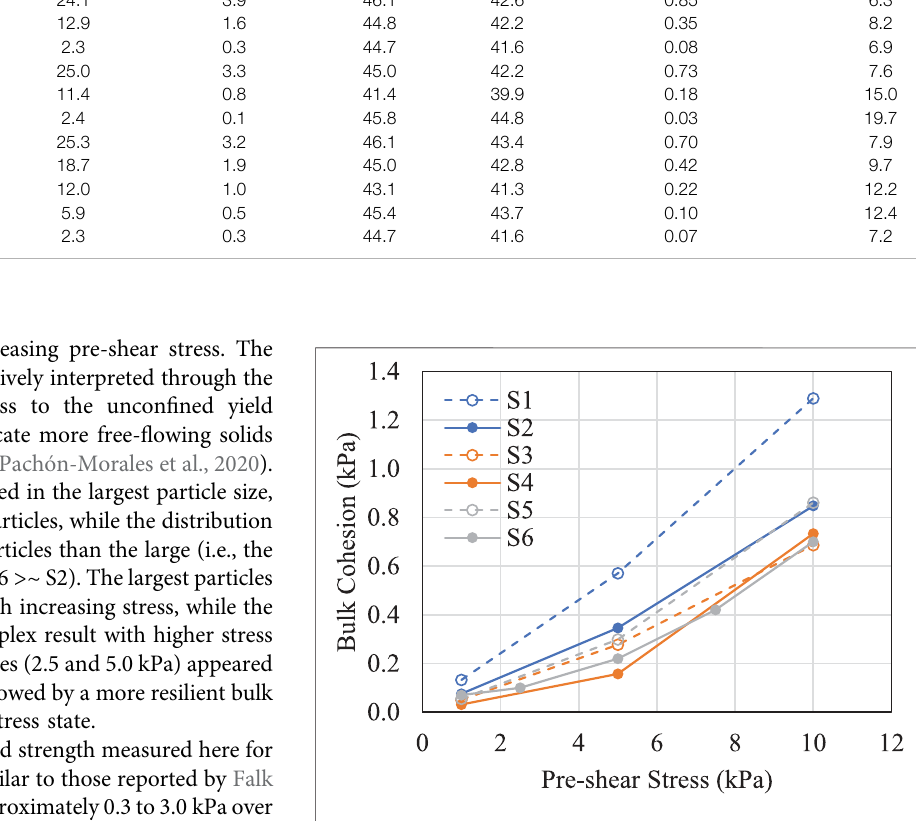
FIGURE 2 | Bulk cohesion for various size classes of loblolly pine under different pre-shear stress